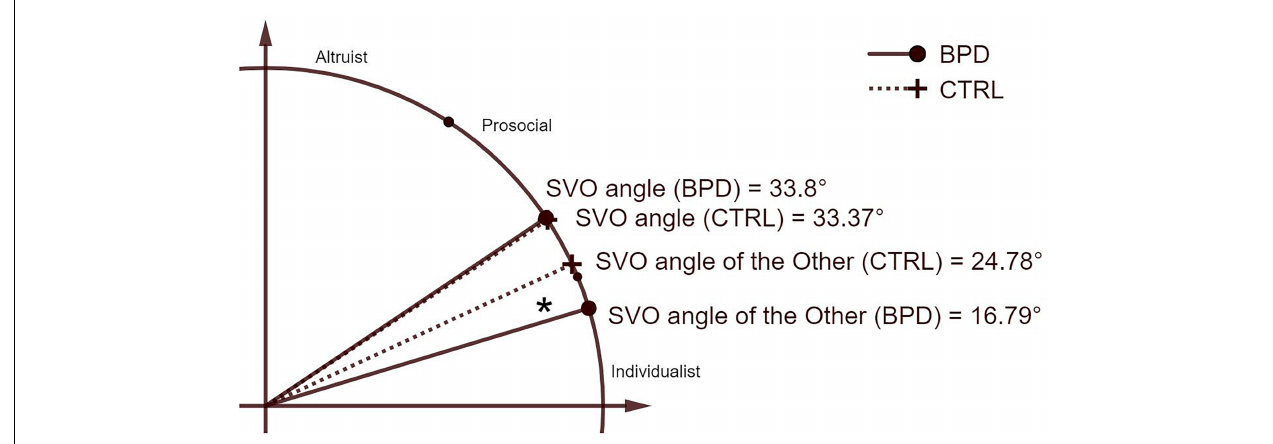
FIGURE 1 | SVO angle differences in the BPD and in the control group. Differences between the borderline (BPD) group and the control (CTRL) group regarding continuous variables of the tasks are depicted in the top right quadrant in the Cartesian plane. Boundaries between SVO categories are indicated with smaller dots (SVO, social value